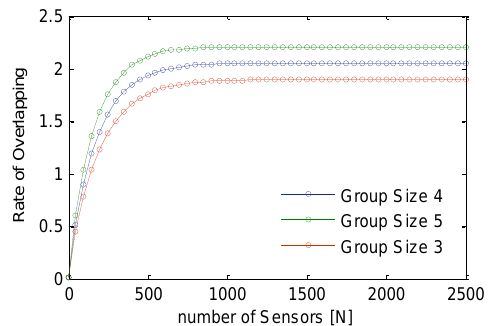
Figure 16. Overlapping rate of GS-IoT with group sizes.